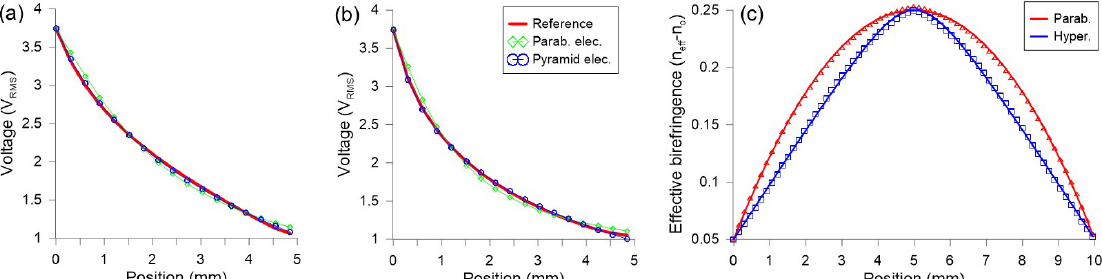
Figure 10. Results of the optimization process for ( a ) hyperbolic and ( b ) parabola phase profiles. The voltage profile of Figure 9b is in a solid red line (Reference) whereas the fitted curves corresponding to parabola-shaped and pyramid-shaped electrodes are green and blue dots, respectively. ( c ) Parabolic (red line) and hyperbolic (blue line) phase profiles based on optimized pyramid-shaped electrodes, solid lines are the canonical equations and dots are the obtained phase profiles by using the optimized pyramid-shaped electrodes.